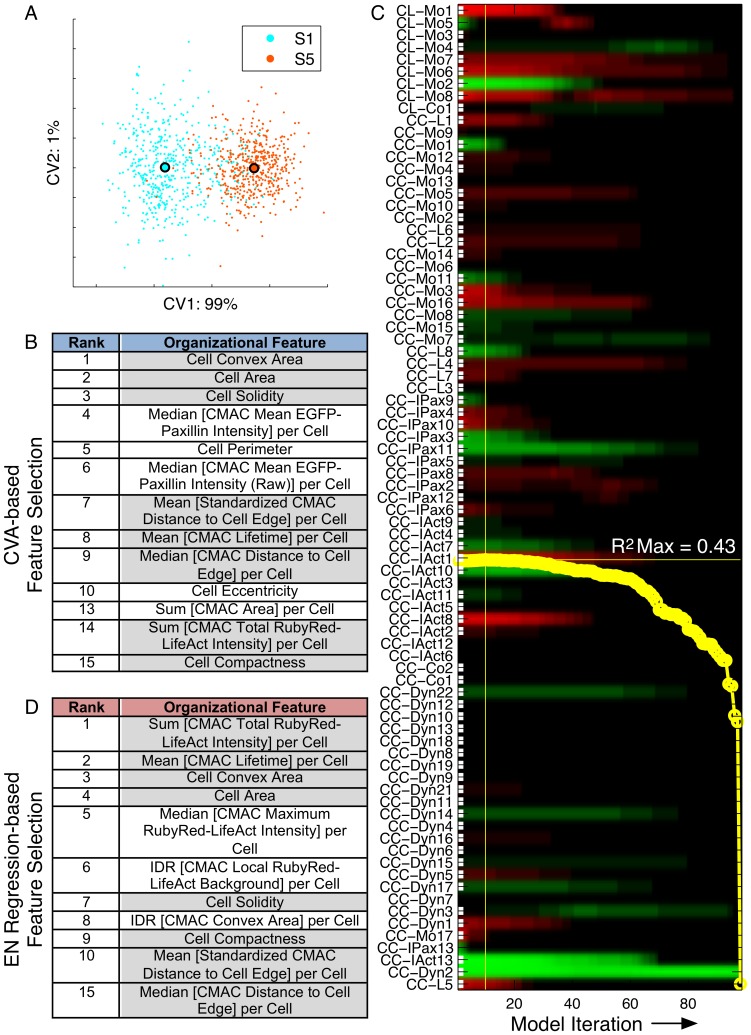
Selection of organizational features associated with Instantaneous Cell Speed (ICS).(A) Comparative CVA clustering of the slowest (S1, 1–20%, blue) and fastest (S5, 81–100%, red) moving Instantaneous Cell Speed (ICS)-defined cell subpopulations using all organizational variables achieves strong separation along the 1st canonical vector (X-axis, captures 99% of total variation). (B) Organizational features driving separation of subpopulations selected by rank ordering according to absolute coefficient values associated with each feature in the 1st canonical vector. (C) 81 normalized organizational features (background variables, Y-axis, compact feature names defined in Supporting Table S1) contribute to EN-regression modeling of ICS (behavioral feature, response variable) for the entire control cell population. Horizontal color bars indicate coefficient values (−1<x<1) (green = negative, red = positive, black = near zero) associated with each variable at any iteration (X-axis) of the modeling process. Red and green variables are positively or negatively correlated with ICS, respectively, while absolute coefficient values indicate the importance of each variable to the estimation of ICS per model iteration. With progressive model iterations, the sum of all coefficient values is forced non-uniformly towards zero, with coefficients redistributed to optimize the regression model according to adjusted R2. (D) Rank ordering of background variables based on their absolute coefficient values in the optimal regression model (adjusted R2 = 0.43, horizontal yellow line, iteration 10, vertical yellow line) provides a second list of organizational features associated with variations in ICS. Variables with grey backgrounds were implicated among the top 15 features by both feature selection methods (B and D).